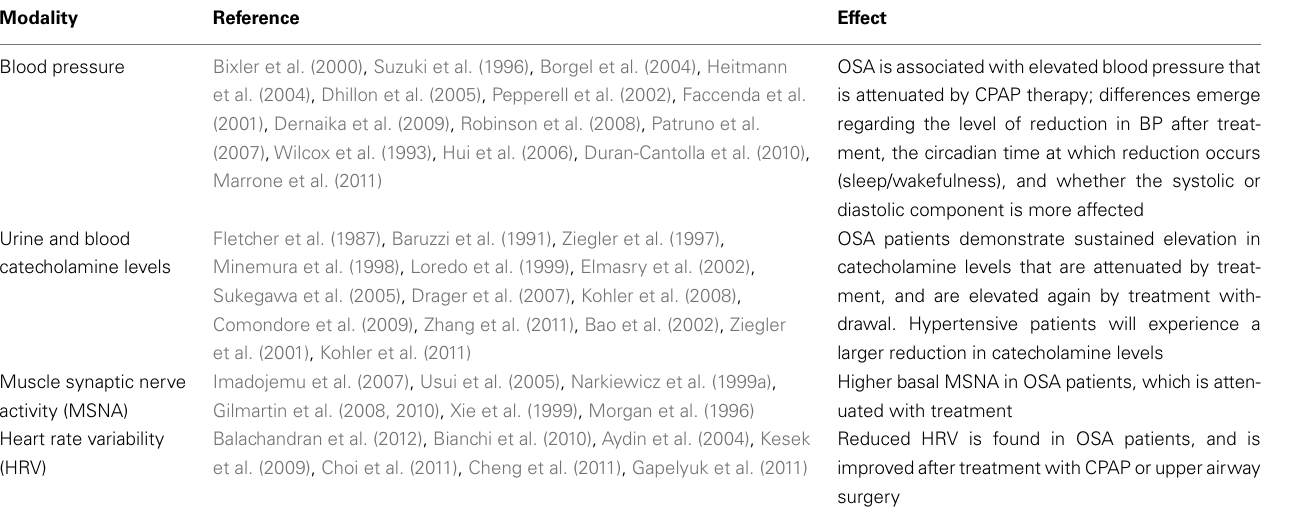
Table 1 | Summary of autonomic nervous system alterations in adult OSA